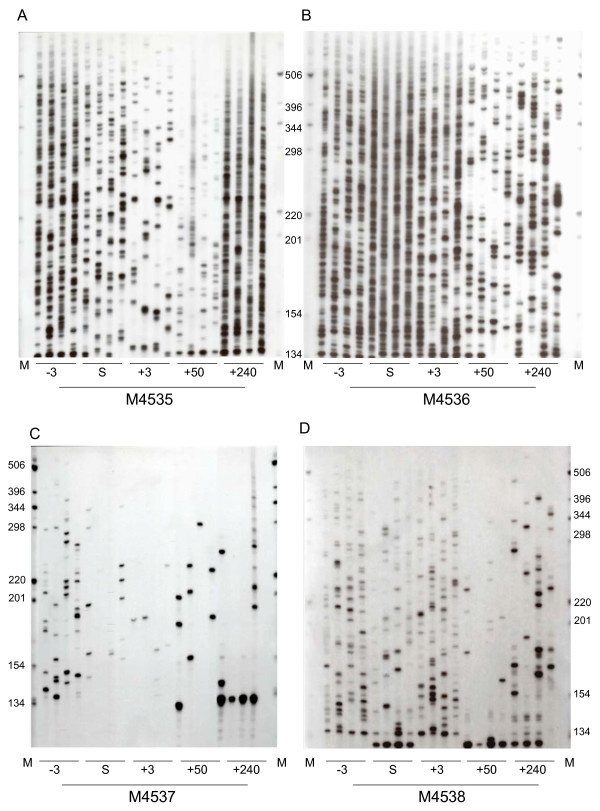
Clonality of BLV-infected cells over time in animals 4535 (A), 4536 (B), 4537 (C), and 4538 (D). Each sample was analyzed in quadruplicate by IPCR as detailed in the Material and Methods section. Each signal on the gel represents a cluster of BLV integration sites having the same length and therefore belonging to the same cellular clone. The absolute detection threshold of the technique was ~21 copies/150,000 PBMCs while samples harboring 1, 2, 3, and 4 signals after quadruplicate experiments corresponded to a BLV clonal frequency of 25 to 62.5, 62.5 to 1200, 1200 to 2400, and > 2400 infected cells per 150,000 PBMCs [4].